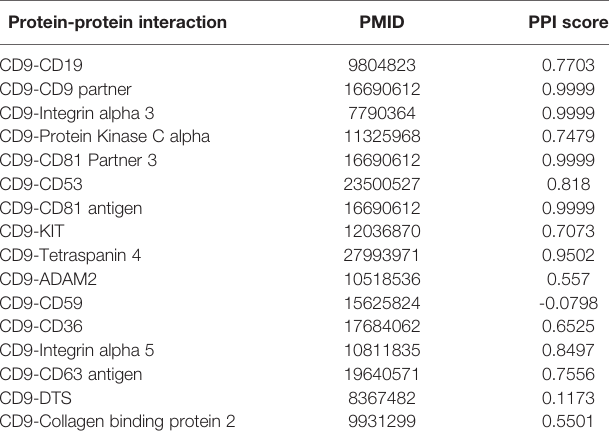
TABLE 7 | Protein-protein interaction information obtained by a web tool PIE. Protein-protein interaction